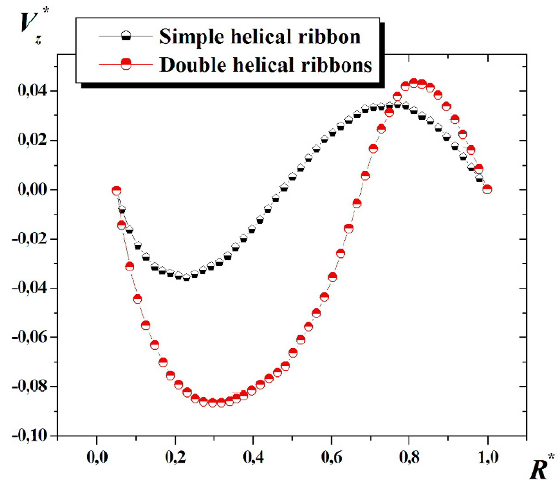
Figure 18. Axial velocity for n = 0.7, Re